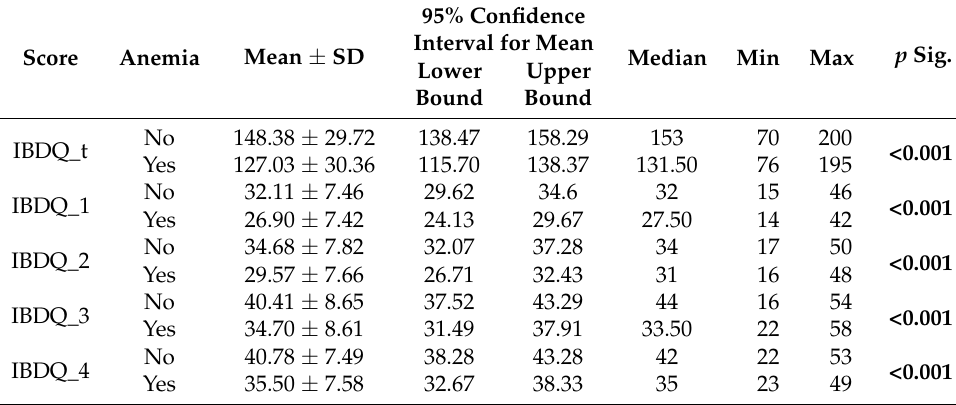
Table 4. Influence of anemia on quality of life.